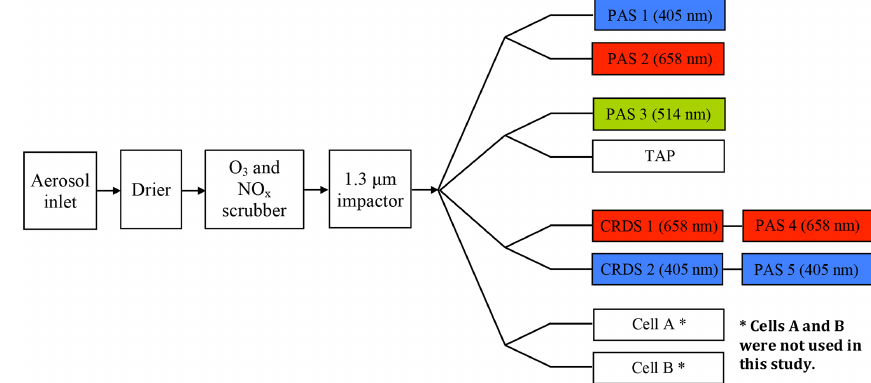
Figure 1. Schematic diagram highlighting the flow conditioning and how the aerosol-laden stream was distributed between the PAS and CRDS cells and the TAP. All PAS and CRDS wavelengths were centred at 405, 514 and 658nm respectively.